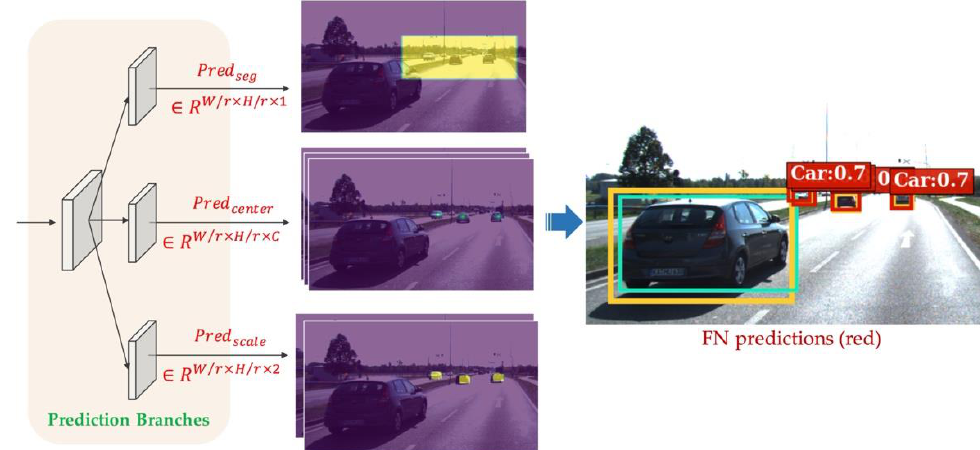
Figure 5. Outputs of prediction branches and the corresponding object-wise FN predictions. Object-wise FN predictions are obtained from the output feature maps, and are denoted as red solid rectangles with category labels in the right image. For better understanding of these FNs, the ground truth objects and detections from the black-box object detector are also provided, which refer to the yellow and green rectangles respectively. Please note that here we crop unrelated background of the image and the feature maps for better visualization.